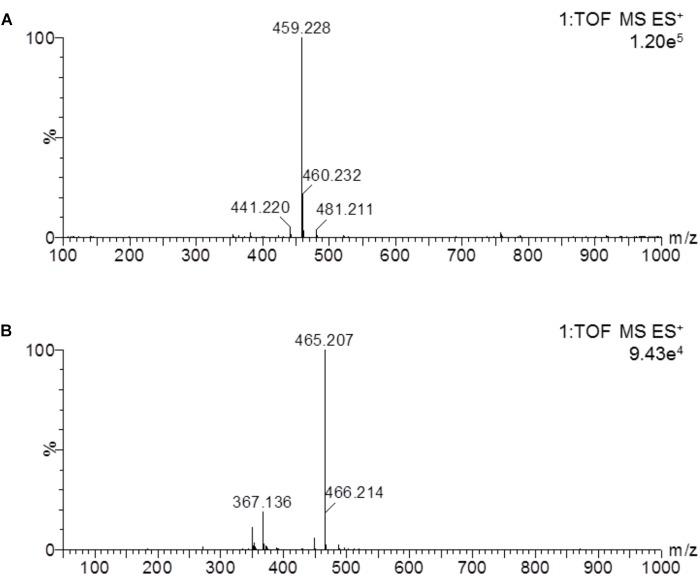
Mass spectrum of cinobufotalin and SNX-2112 in a prepared rat plasma sample. The results showed the molecular ion 459.228 [M+H]+ of cinobufotalin (A) and 465.207 [M+H]+ for SNX-2112 (B).